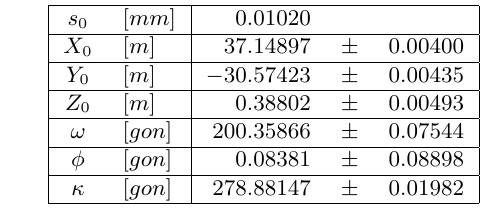
Table 2: Parameters of the exterior orientation